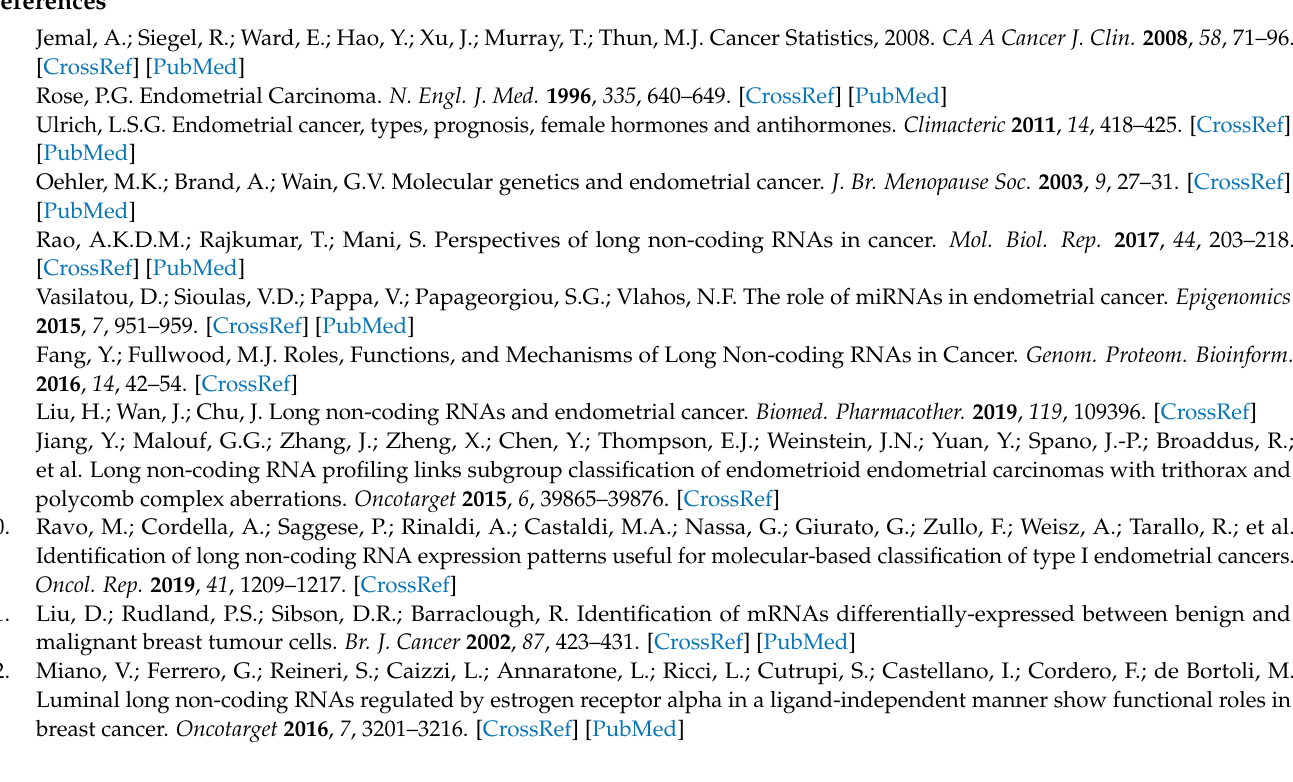
OS. Figure S3: Genes being most significantly downregulated after DSCAM-AS1 knockdown in HEC- 1B cells, shown is their association with OS. Figure S4: Genes being strongly downregulated after DSCAM-AS1 knockdown in EC cells, shown is their correlation with DSCAM-AS1 in endometrial adenocarcinoma tissues. Table S1: Sequences of primers used for RT-qPCR. Table S2: Gene Set Enrichment Analysis (GSEA) of genes up- or downregulated upon DSCAM-AS1 knockdown in HEC-1B cells [30]. Supplementary file S1: Genes correlated with DSCAM-AS1 (R-value cut off